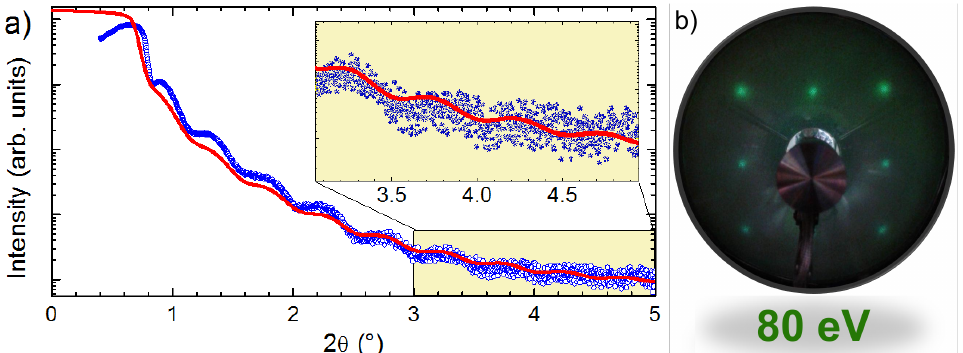
Figure 3. ( a ) low-angle X-ray reflectivity of a SRO film grown on a (110)-oriented NGO (blue circles along with the simulated curve (red); ( b ) LEED patterns of a SRO film grown on a (110)-oriented NGO taken with electron energy of 80 eV.